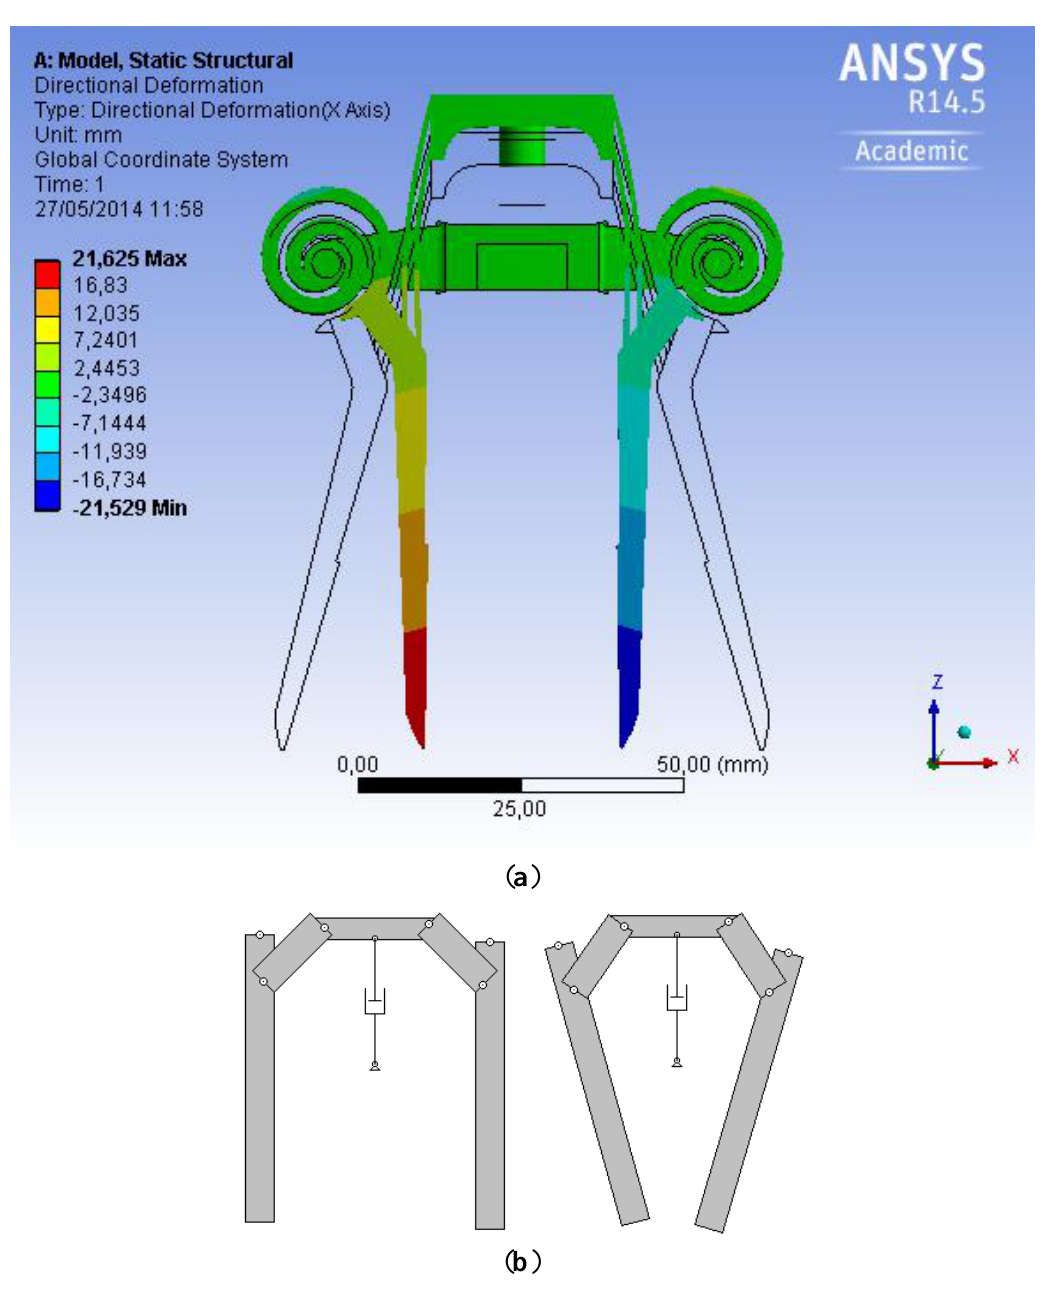
Figure 6. ( a ) Angular gripper mechanism, fingers and chassis all made in a single plastic piece, without shafts and actuated with a double effect pneumatic cylinder. ( b ) Equivalent gripper designed with rigid